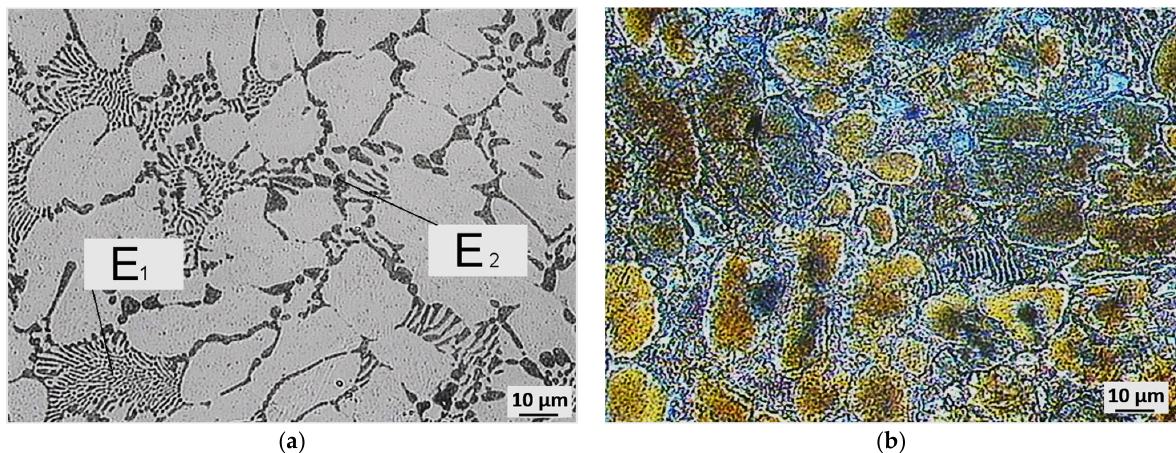
Figure 9. Microstructure of the ZnAl4Cu3 sample after ninth melting (P9 alloy): ( a ) etched 0.5% HF and ( b ) etched Dix–Keller.